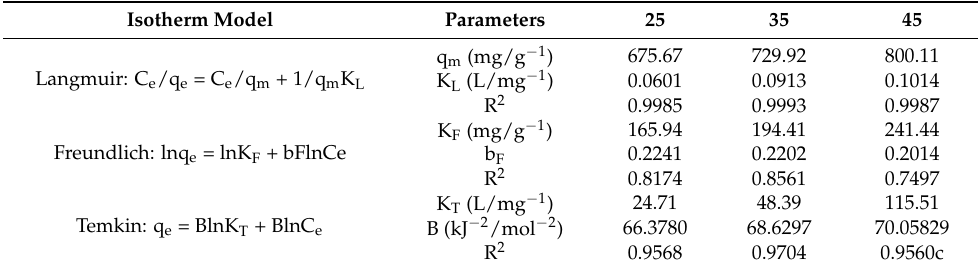
Figure 5. ( a ) Adsorption isotherms of Cr (VI) by DAPFP at pH = 2.0 and 25 °C; ( b ) Freundlich isotherm model plots; ( c ) Langmuir isotherm model plots and ( d ) Temkin model plots. Table 2. Parameters of the adsorption isotherm of DAPFP at 25 ◦ C (pH =